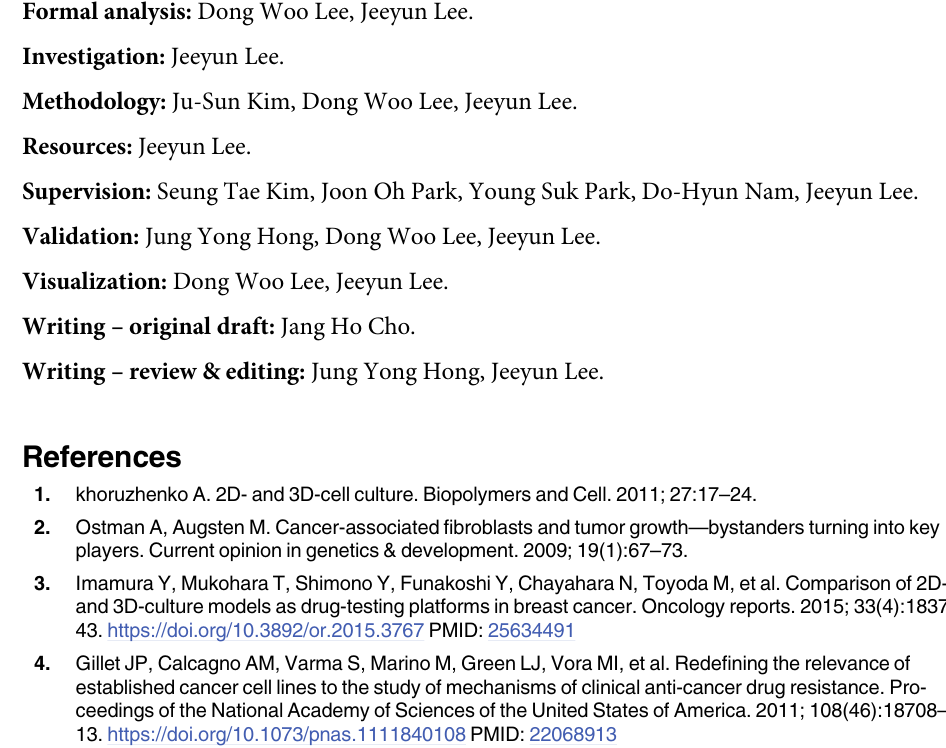
S1 Table. Twenty-four drugs screened for five gastric cancer cell lines and patient-derived cancer cell lines and the target genes of each